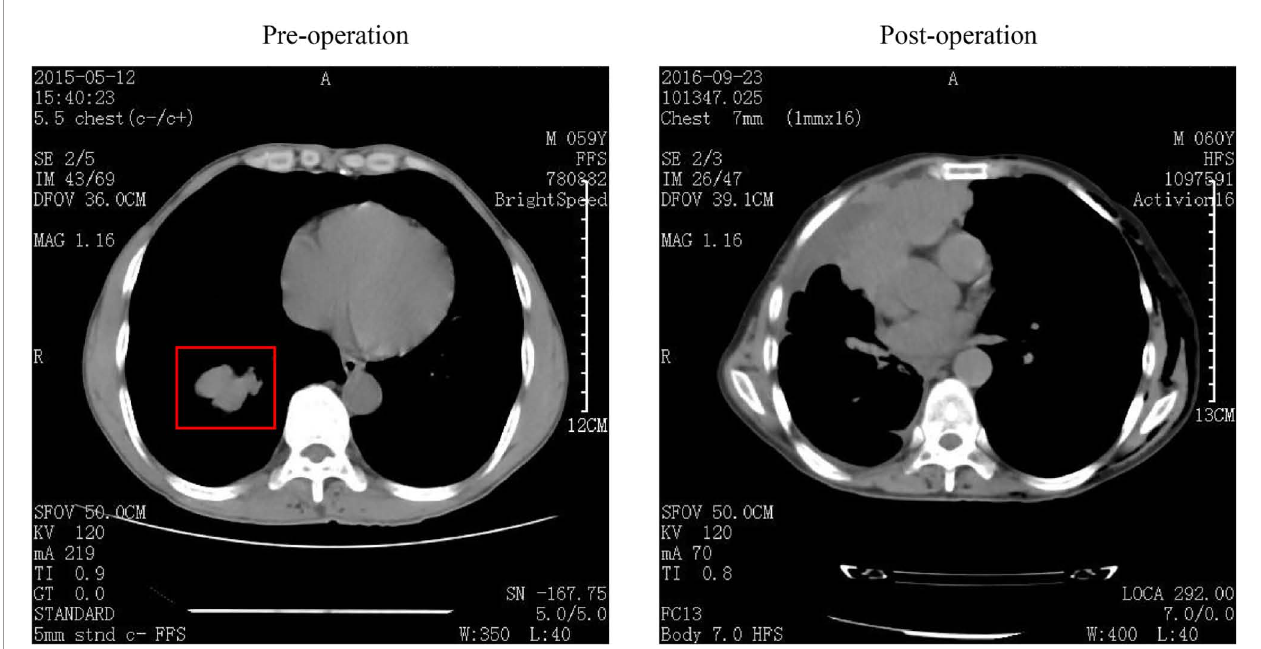
FIGURE 1 | Computedtomography(CT)imagesofthis patient. CT imagewas collectedbefore(left) andafter(right) surgery,andthetumormass